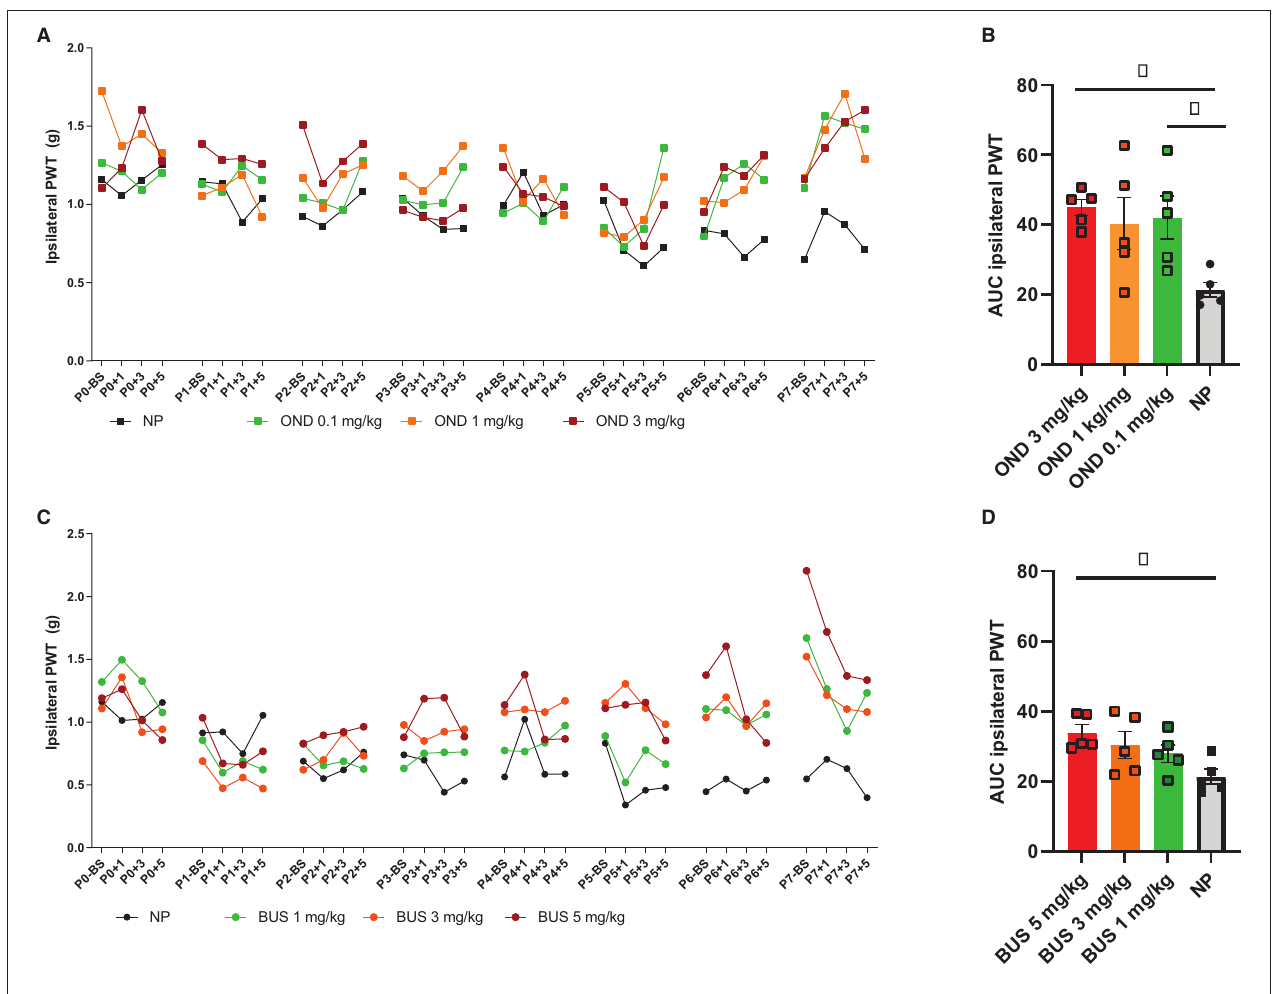
FIGURE 1 | Dose-response pilots of ondansetron (0.1, 1, and 3 mg/kg) and buspirone (1, 3, and 5 mg/kg). (A) PWTs increase over time, but not equally for all conditions [F (93, 636) = 4.841; p < 0.01]. Repetitive needle pricking (NP; n = 12) results in a decreased paw-withdrawal threshold (PWT) over time, that was significantly different from OND 3 mg/kg from P5 onwards. (B) The area under the curve (AUC) over the entire neonatal period is significantly different between neonatal conditions for the ipsilateral paw-withdrawal thresholds (PWT) [F (3, 16) = 4.432; p = 0.0189]. AUC was significantly increased in NP animals after administration of 0.3 mg/kg ( p = 0.0329) and OND 3 mg/kg ( p = 0.0143), as compared to NP animals receiving saline. (C) PWTs increase over time, but not equally for all groups [F (93,496) = 2.600; p < 0.01]. Repetitive needle pricking (NP) results in decreased PWTs over time, that was significant different from BUS 1 mg/kg from P5 onwards, from BUS 3 mg/kg from P4 onwards and BUS 5 mg/kg from P3 onwards. (D) The AUC over the entire neonatal period is significantly different between conditions [F (3, 16) = 3.745; p = 0.0327]. NP animals receiving BUS 5 mg/kg showed significantly increased AUC as compared to NP animals receiving saline ( p = 0.0151). BS, baseline measurement; NP, needle pricking animals; BUS, buspirone; OND, ondansetron; P (0–7), postnatal day 0–7; + 1, + 3, + 5, measurement 1, 3 and 5 h after needle prick or tactile stimulation. Data is presented as mean ± SEM, NP vs. NP + BUS. * P <